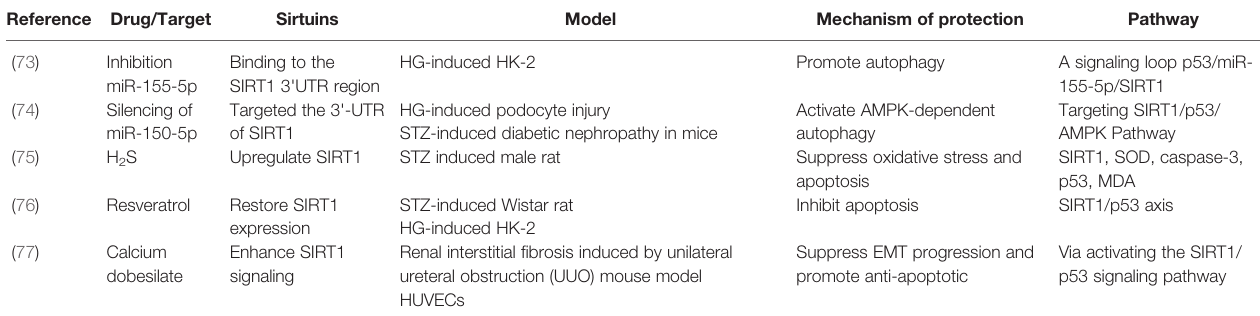
TABLE 3 | DKD studies on SITR1/p53 pathway.